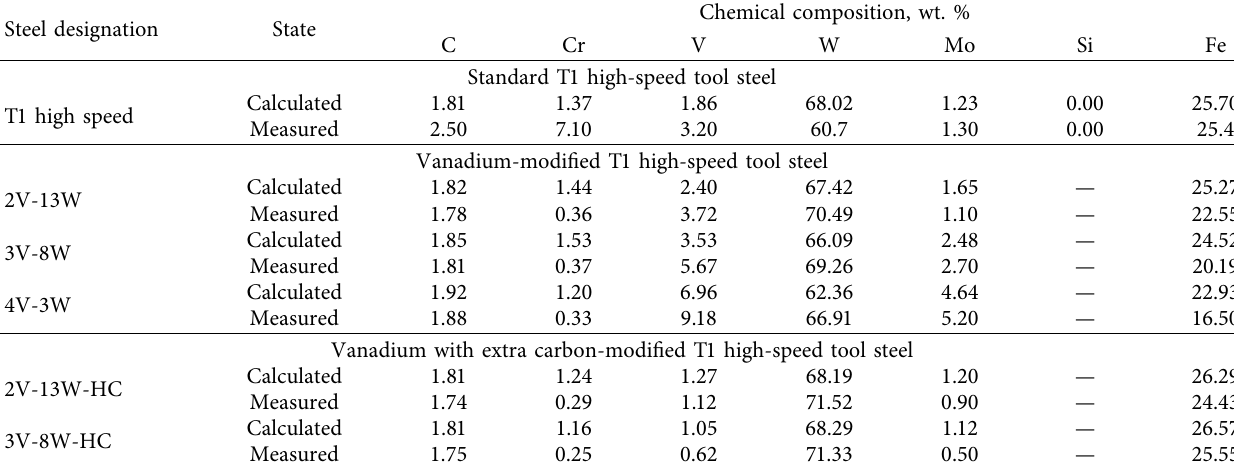
6 C carbide for T1 high-speed tool steel and its diferent variants (as solidifed).